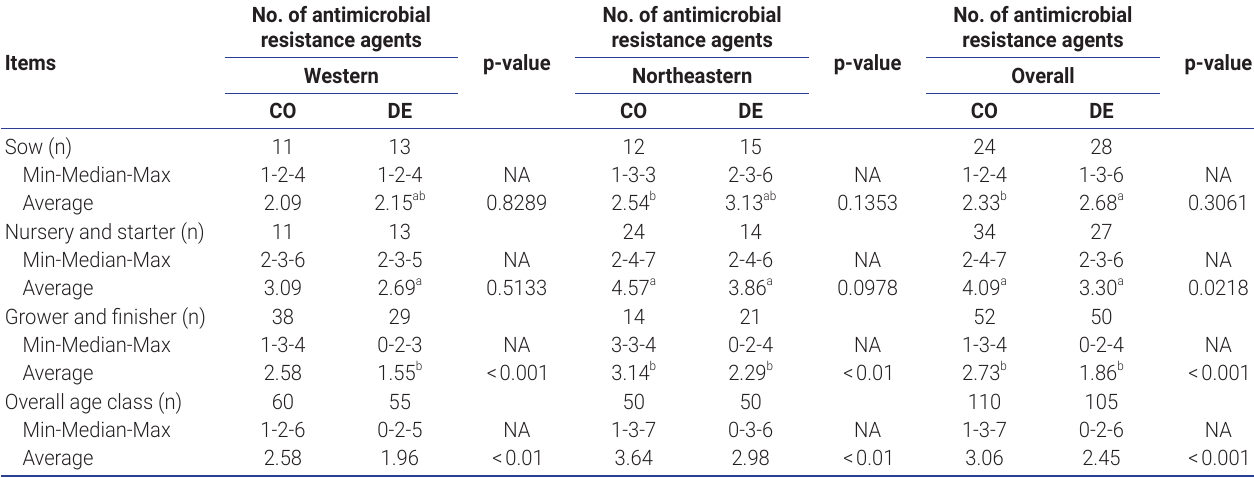
Table 3. Quantity aspect of antimicrobial resistance in Escherichia coli isolates from the conventional system (CO) and the deep litter system (DE) of the current study